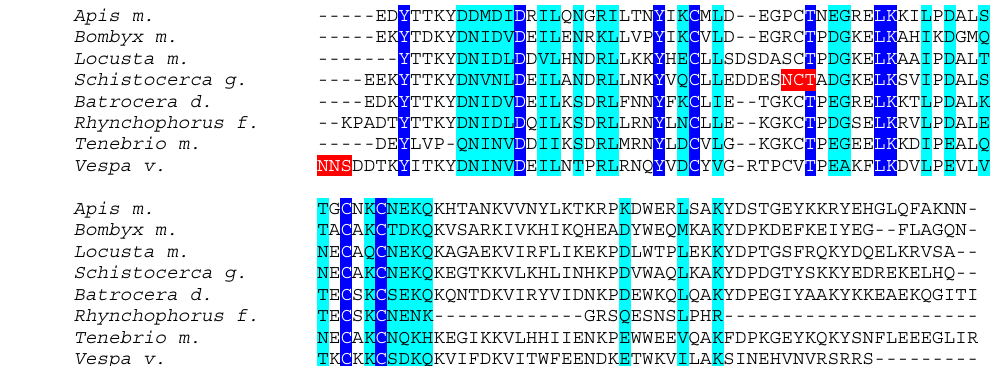
Figure 2. Multiple amino acid sequence alignment of chemosensory proteins from Apis mellifera ( Apis m. ), Bombyx mori ( Bombyx m. ), Locusta migratoria ( Locusta m. ), Schistocerca gregaria ( Schistocerca g. ), Bactrocera dorsalis ( Bactrocera d. ), Rhynchophorus ferrugineus ( Rhynchophorus f .), Tenebrio molitor ( Tenebrio m. ), and Vespa velutina ( Vespa v. ). Identical amino acids are displayed in white letters highlighted in blue, homologous amino acids are displayed in black letters highlighted in cyan, and putative N -glycosylation sites are highlighted in red. Figure 3. A. Superposition of the ribbon diagrams of chemosensory proteins from Apis mellifera (blue), Bombyx mori (red), Bactrocera dorsalis (green), Locusta migratoria (purple), Schistocerca gregaria (yellow) and Tenebrio molitor (orange).